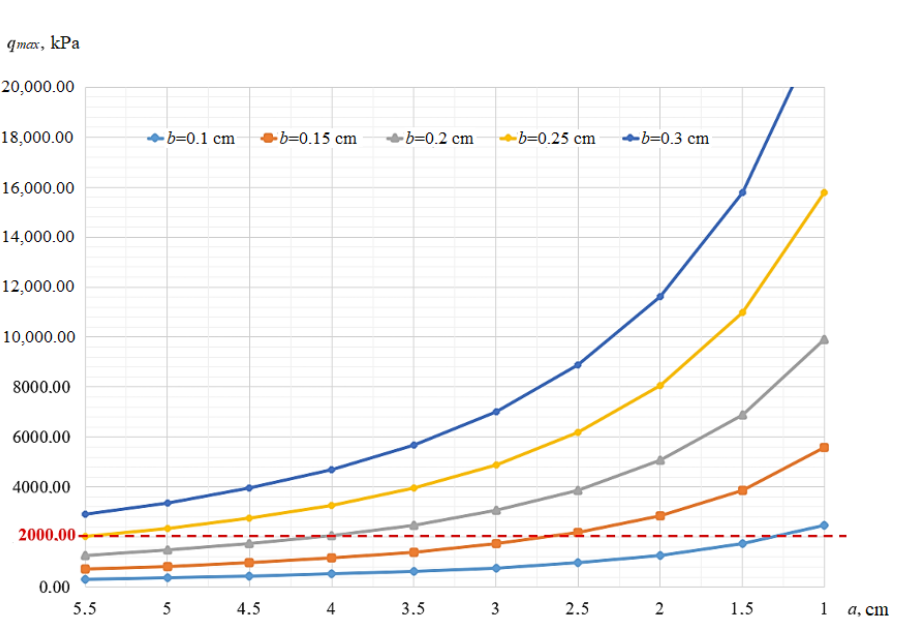
Figure 7. Graph of the dependence of the maximum allowable intensity of the external transverse load ( q max ) on the working cover on various configurations of its overall